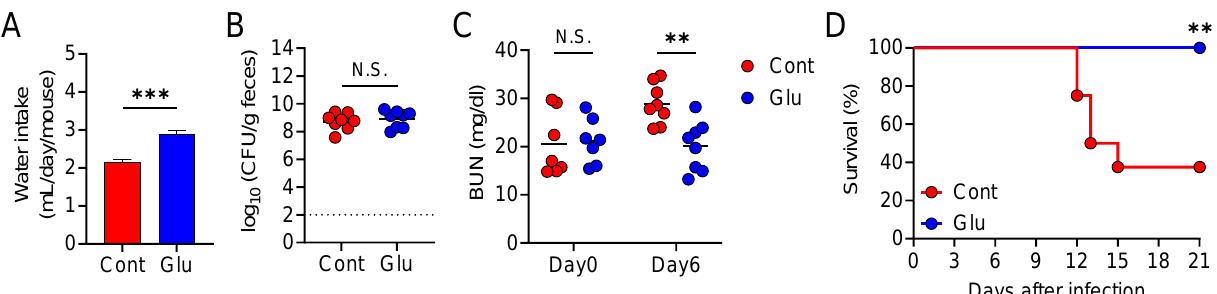
Figure 6. Oral glutamate treatment protects mice from lethal diarrheal Citrobacter rodentium infection. ( A ) Mice were treated with or without 1% glutamate for 10 days. Water intake of each group. Data are expressed as mean ± SD. ( B – D ) Mice treated with or without 1% glutamate were infected orally with C. rodentium ( n = 8 in each group). ( B ) Fecal pathogen load 6 days post-infection. ( C ) Blood urea nitrogen (BUN) level 0 and 6 days post-infection. ( D ) Mouse survival. Each dot represents an individual mouse and the horizontal bars indicate mean values. Statistical significance was assessed by ( A , B ) unpaired Student’s t -test or ( C ) two-way ANOVA with Šídák’s multiple comparisons test. ** p < 0.01; *** p < 0.001; N.S., not significant.